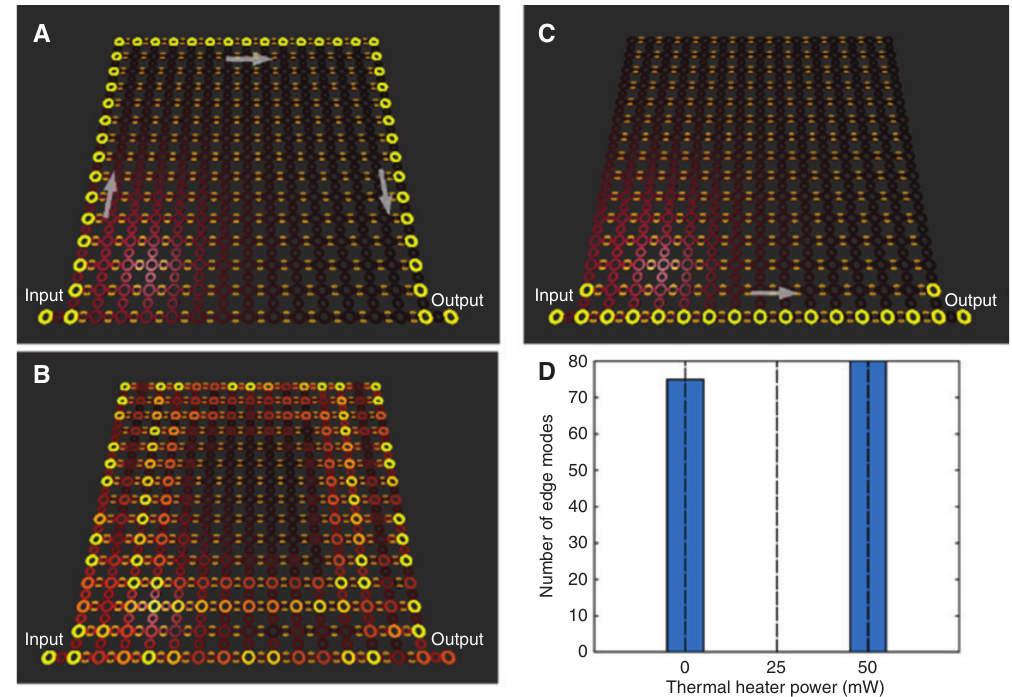
Figure 3: (A–C) Field distributions of 15 × 15 resonator array for three different cases at working wavelength λ = 1.305 μ m. (A) thermal heaters are off, which corresponds to the topologically protected state at (1) 0.5, α = which corresponds to an input power of 25 mW applied to each heater; and (C) topologically protected state (3) trivial state (2) M which corresponds to an input power of 50 mW applied to each heater. (D) Number of edge modes corresponding to three different states. Direction of propagation is indicated by